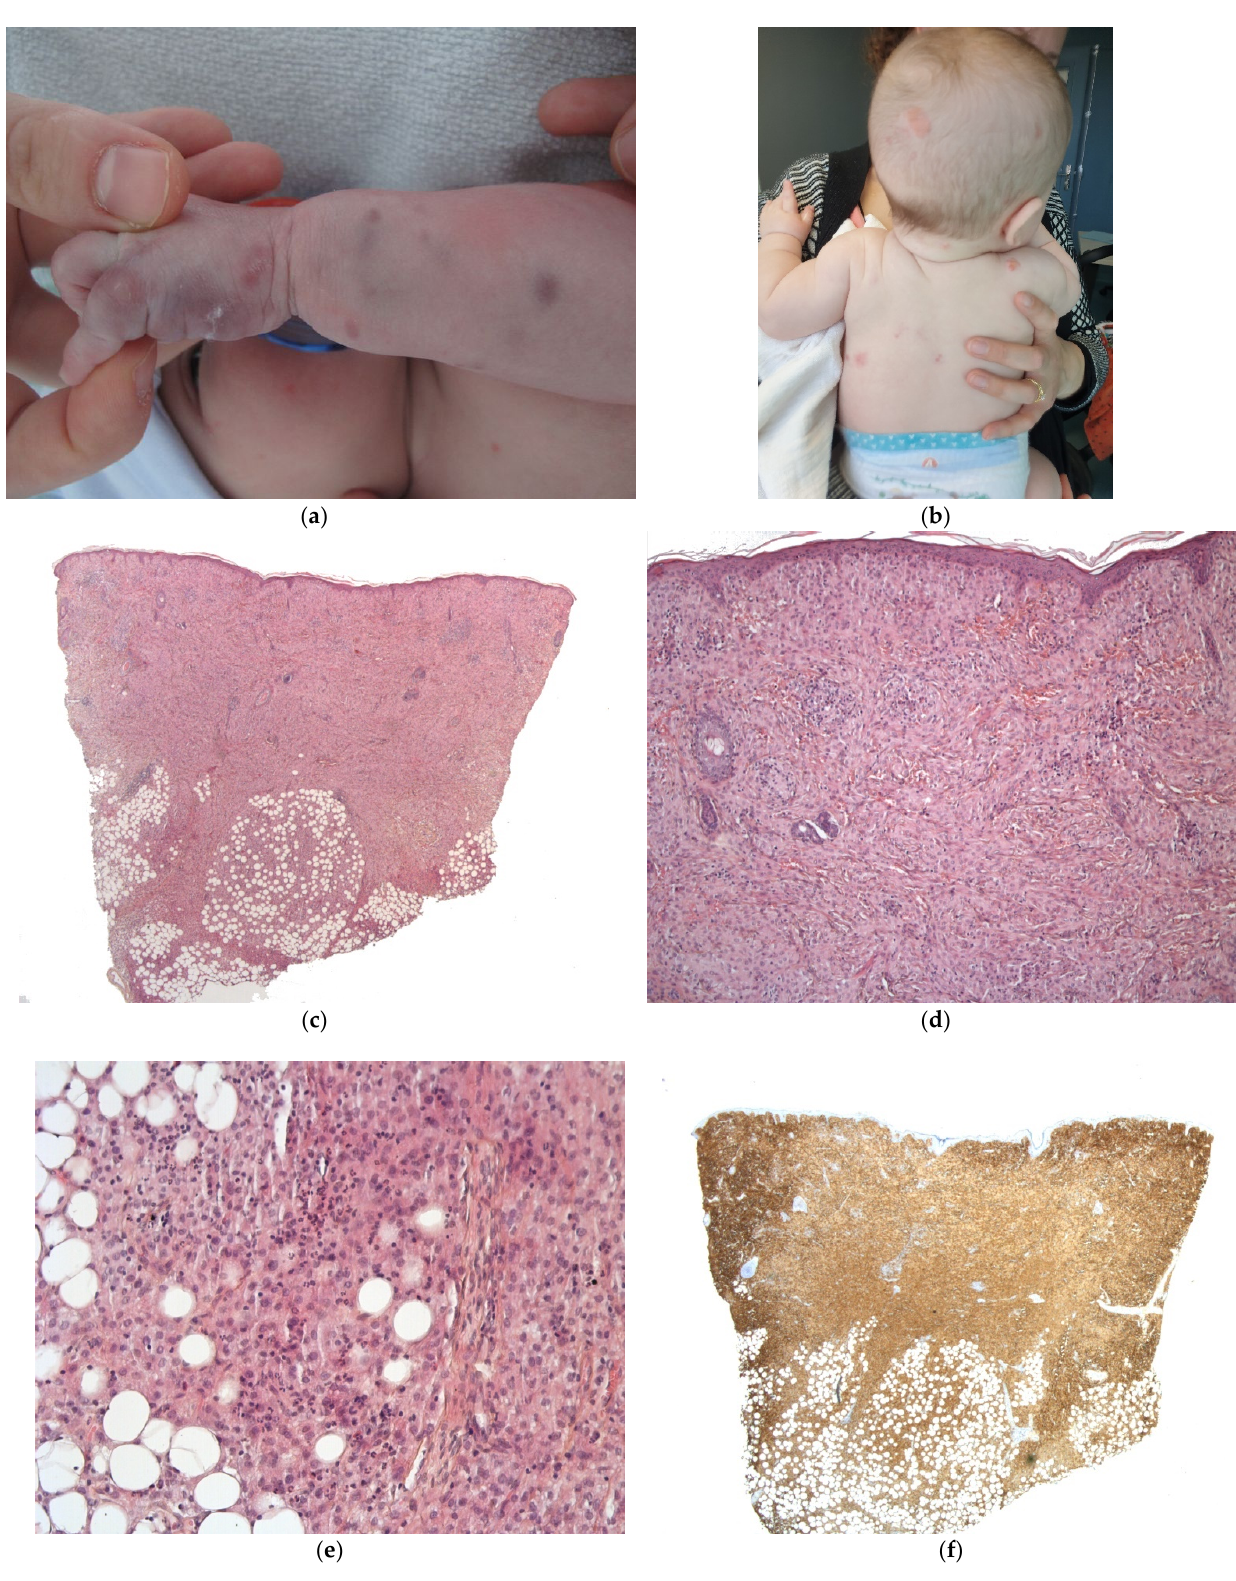
Figure 8. Juvenile xanthogranuloma. ( a ) Presenting as blueberry muffin rash (by courtesy E Puzenat); ( b ) multiple yellowish lesions. ( c ) 4× rather dense infiltrate in the dermis extending into the superficial subcutis. ( d ) 10× non xanthomized histiocytes with no giant cells (mononuclear-vacuolated early variant). ( e ) 25× Histiocytes are accompanied by inflammatory cells, in particular here, neutrophils. ( f ) Anti-Factor XIIIa positivity.